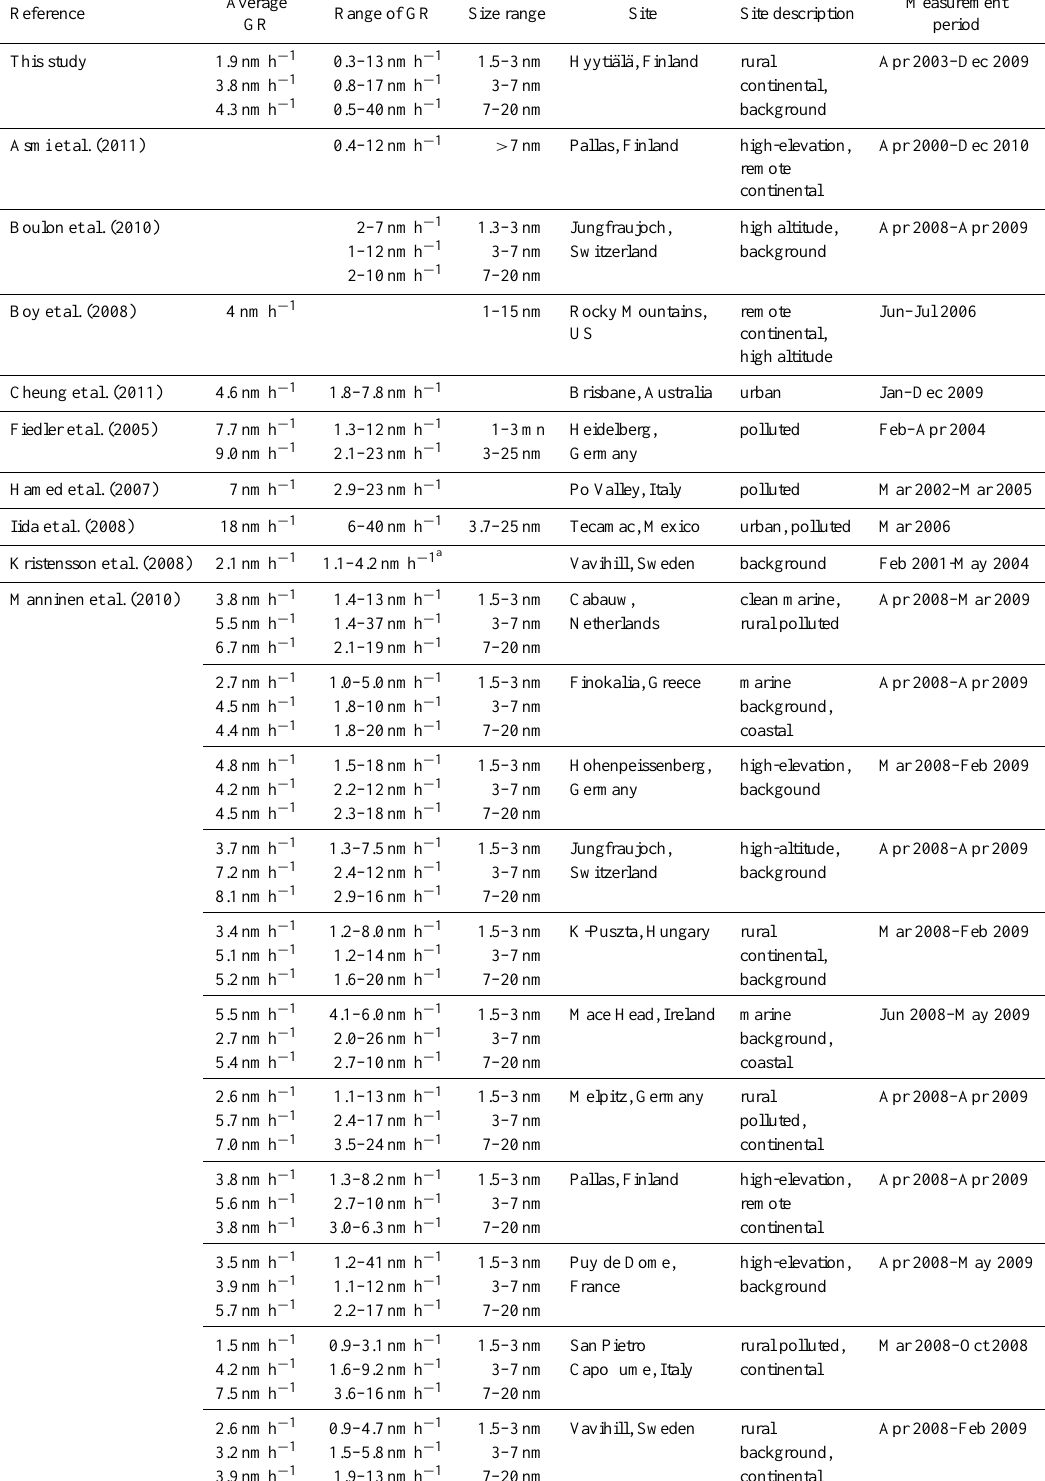
Table 1. Nucleation mode particle growth rates reported in some of the recent studies. Average (mean or median), range of GR and the size range for which the GR values were calculated are listed (if reported in the